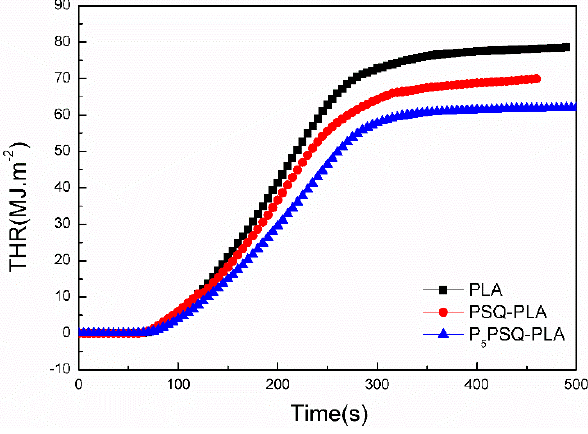
Figure 4. Heat release rate versus time curves of PLA and its flame retardant composites. Polymers 2019 , 11 , x FOR PEER REVIEW